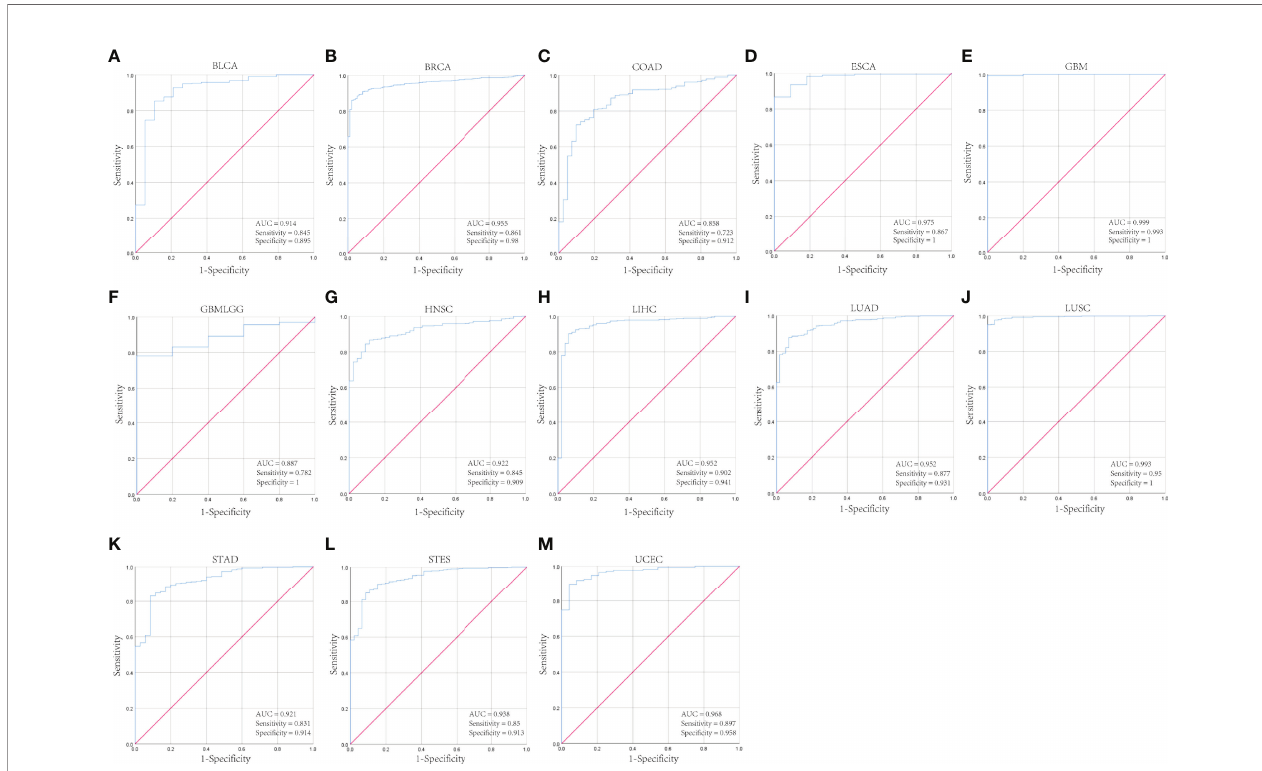
FIGURE 2 | The diagnostic value of CENPL in pan-cancer. (A – M) . The ROC curves of CENPL in BLCA, BRCA, COAD, ESCA, GBM, GBMLGG, HNSC, LIHC, LUAD, LUSC, STAD, STES, UCEC.